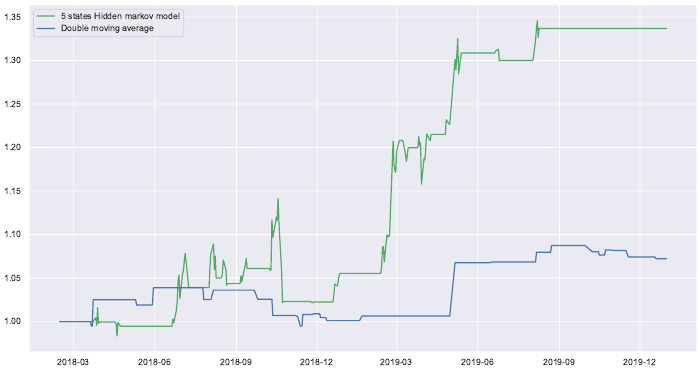
Figure 8. Comparison of the yield index curve of the five hidden states hidden Markov situation estimation trading strategy and the double moving average